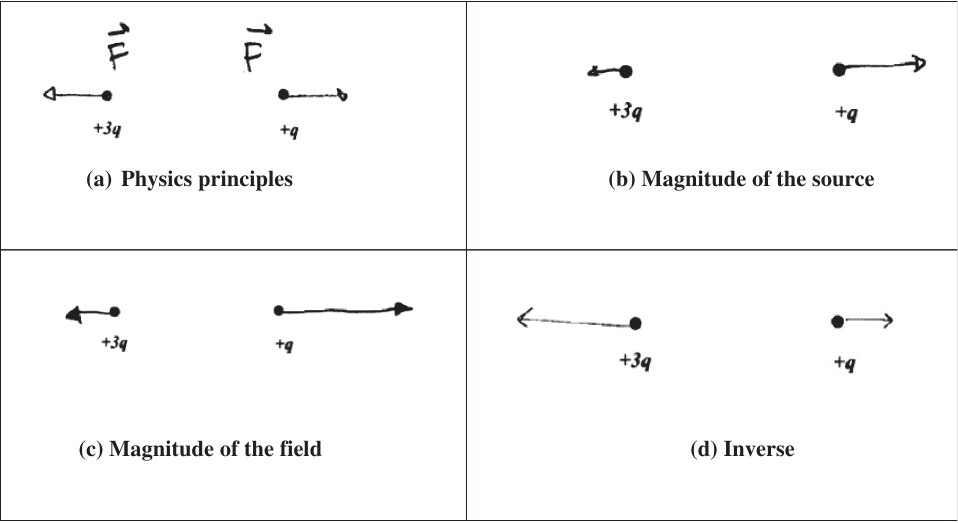
FIG. 11. Student diagram examples for each category of item 3 in the electricity